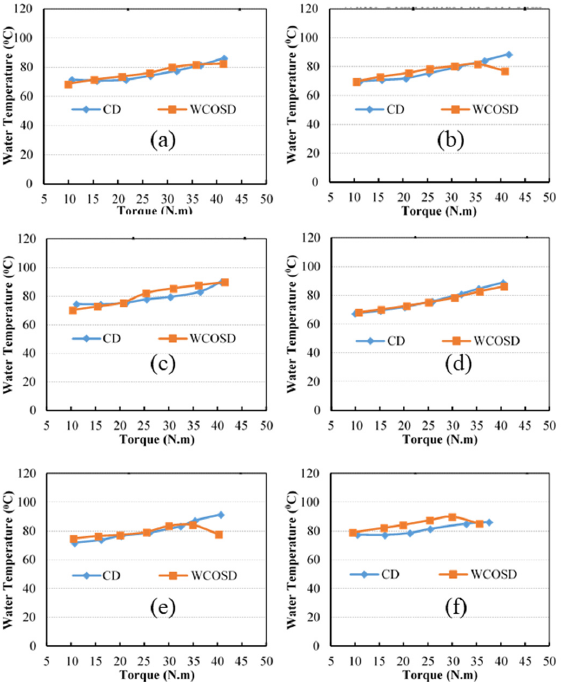
Figure 7. Cooling water temperatures at partial loads and different engine speeds: ( a ) at 1200 rpm, ( b )